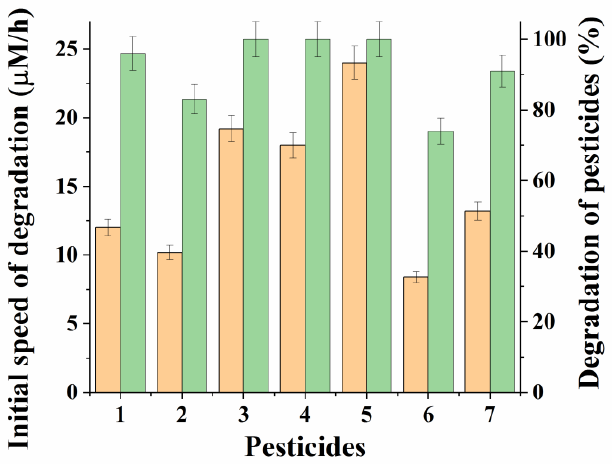
(cid:4) initial speed and (cid:4) degradation degree) of various OPPs (0.15 mM) Figure 3. Degradation ( ◼ initial speed and ◼ degradation degree) of various OPPs (0.15 mM) by Figure 3. Degradation (